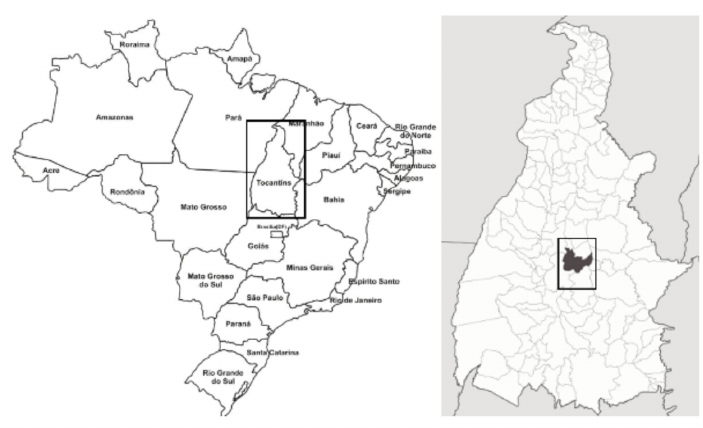
Figure 1. Geographic location of the state of Tocantins and the city of Palmas, in